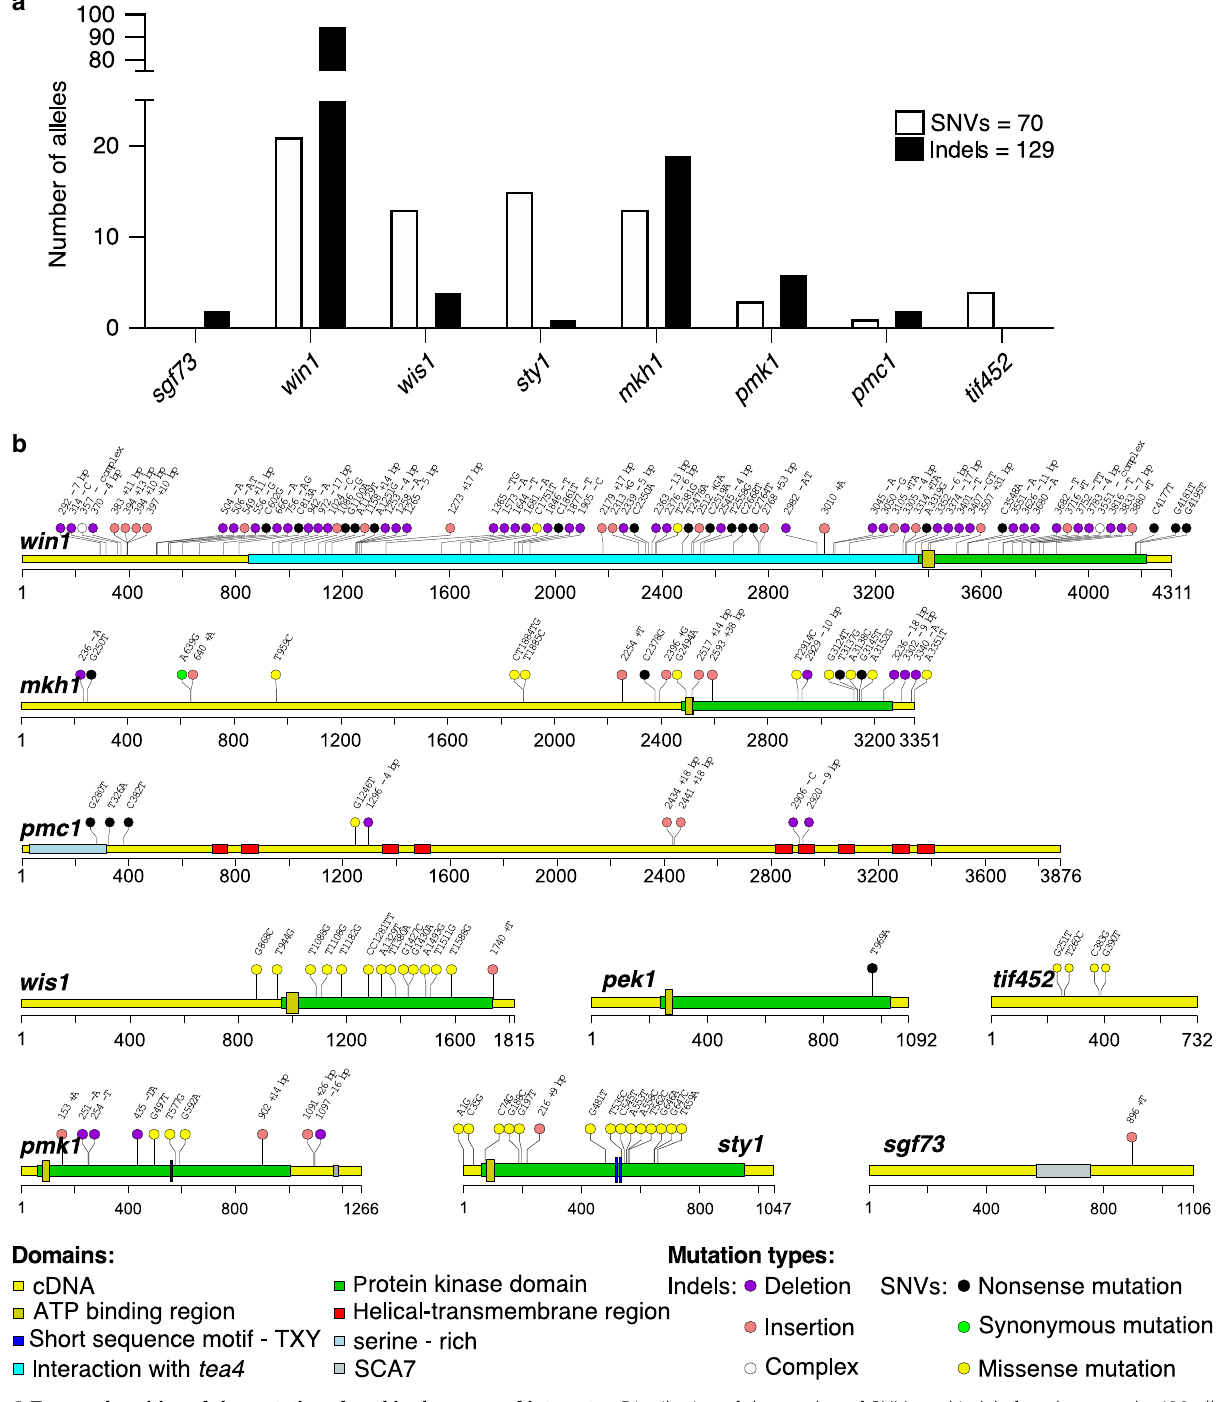
Fig. 3 Type and position of the mutations found in the genes of interest. a Distribution of the number of SNVs and indels found among the 199 alleles identi fi ed by targeted resequencing of cultures 1 – 3 and subcultures 1 – 6. In cultures 1 – 3, mutations found at both 2 and 3 months were counted only once. b Mutations in the nine genes of interest identi fi ed by WGS and by targeted resequencing. Known domains and mutation types are